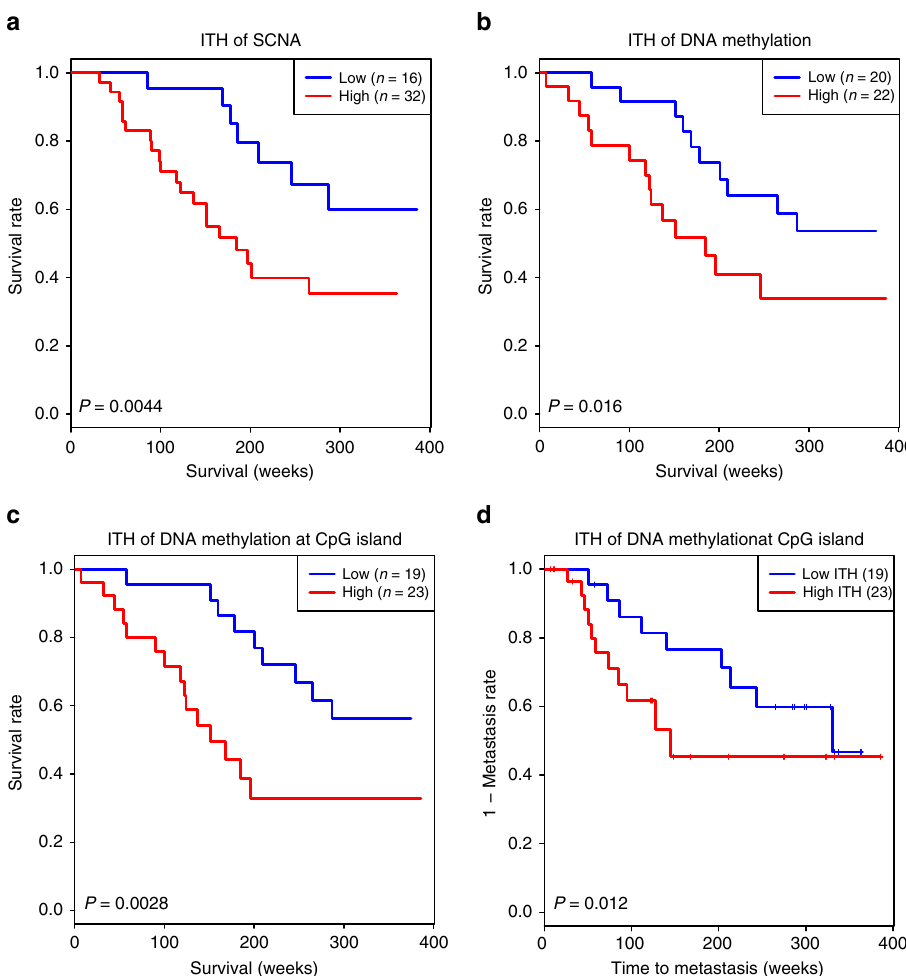
Fig. 7 Kaplan – Meier curves of overall survival. Kaplan – Meier estimates of overall survival in patients with high and low ITH of a SCNAs, b DNA methylation based on the top 5000 most variable CpG probes and c DNA methylation at CpG islands. d Kaplan – Meier estimates of metastasis in patients with high and low ITH of DNA methylation at CpG islands. High and low ITH groups were strati fi ed by median APITH and colored in red and blue, respectively. The p -values were calculated using the Cox proportional-hazards model weighted by the variance of the estimated APITH. Sample size for each group is indicated in the fi